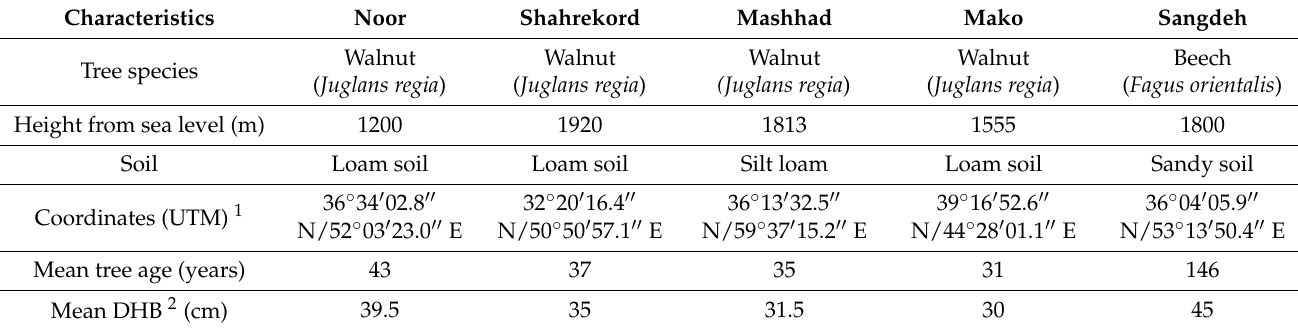
Table 1. Main features of the selected trees and areas where wood samples were collected. Characteristics